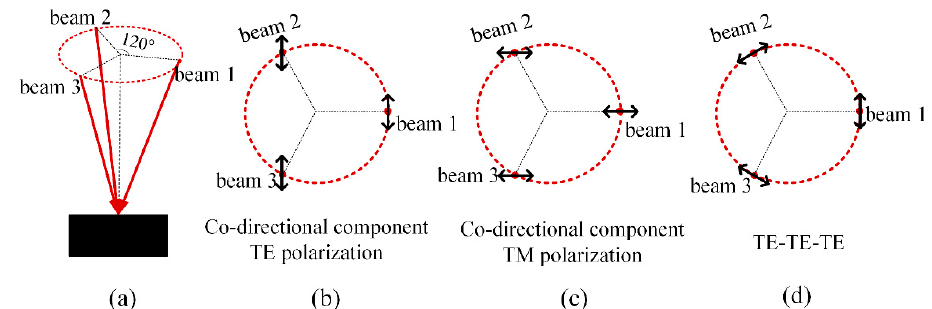
Figure 8. Schematic diagram of polarization mode of three-beam interference. ( a ) The incident azimuth of the interference of the three beams. ( b – d ) Three different types of polarization mode combinations, the arrows represent the polarization direction of the beams on the x-y plane.